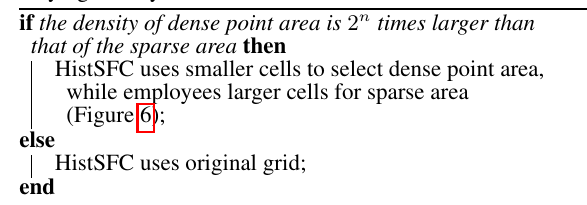
Algorithm 1: Query optimization for a point cloud with varying